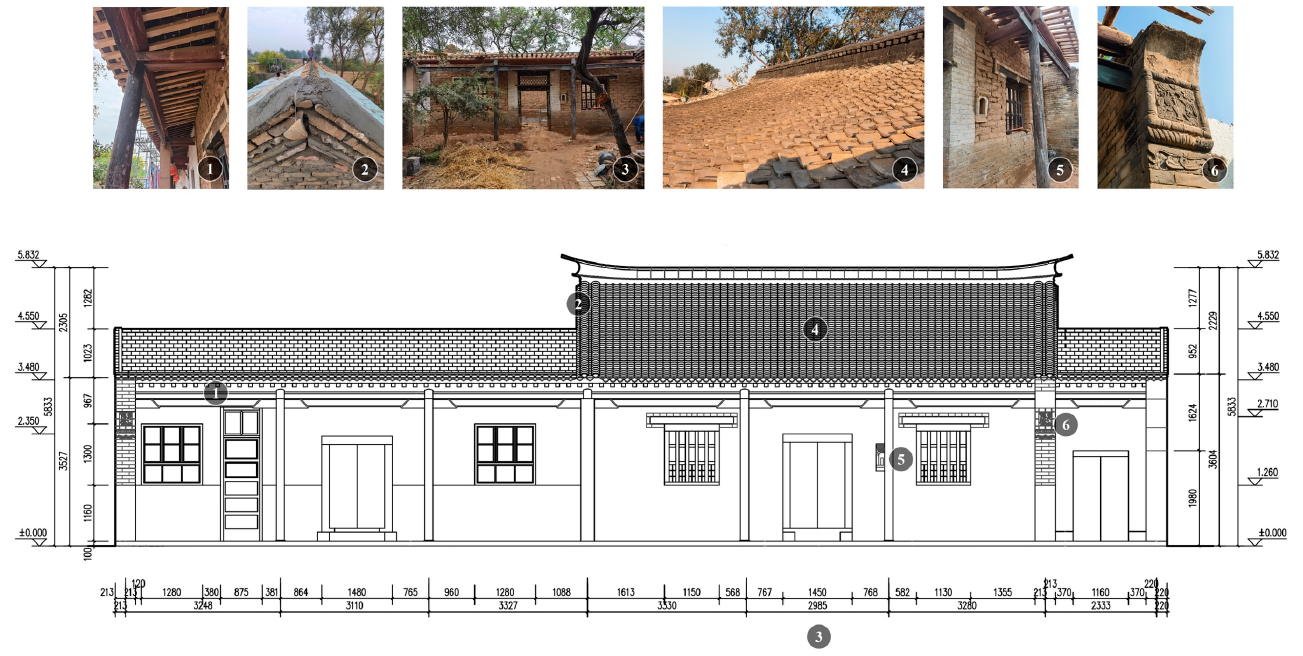
Figure 10. Building and courtyard façade and main